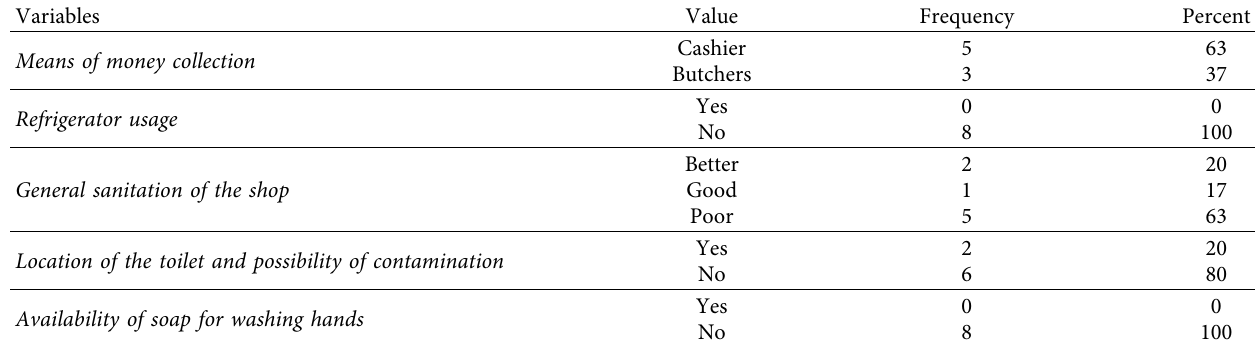
Table 2: Hygienic data collected from the butcher shops by visual observation.